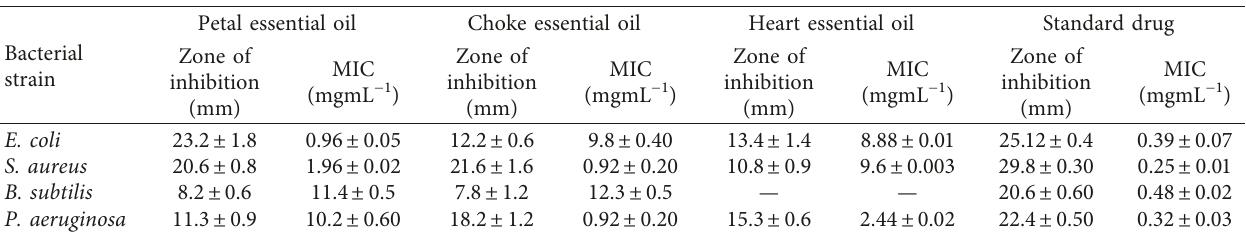
Table 3: Antibacterial activity of essential oil extracted from the petal, choke, and heart of C. scolymus L. head against four bacterial strains. Bacterial strain